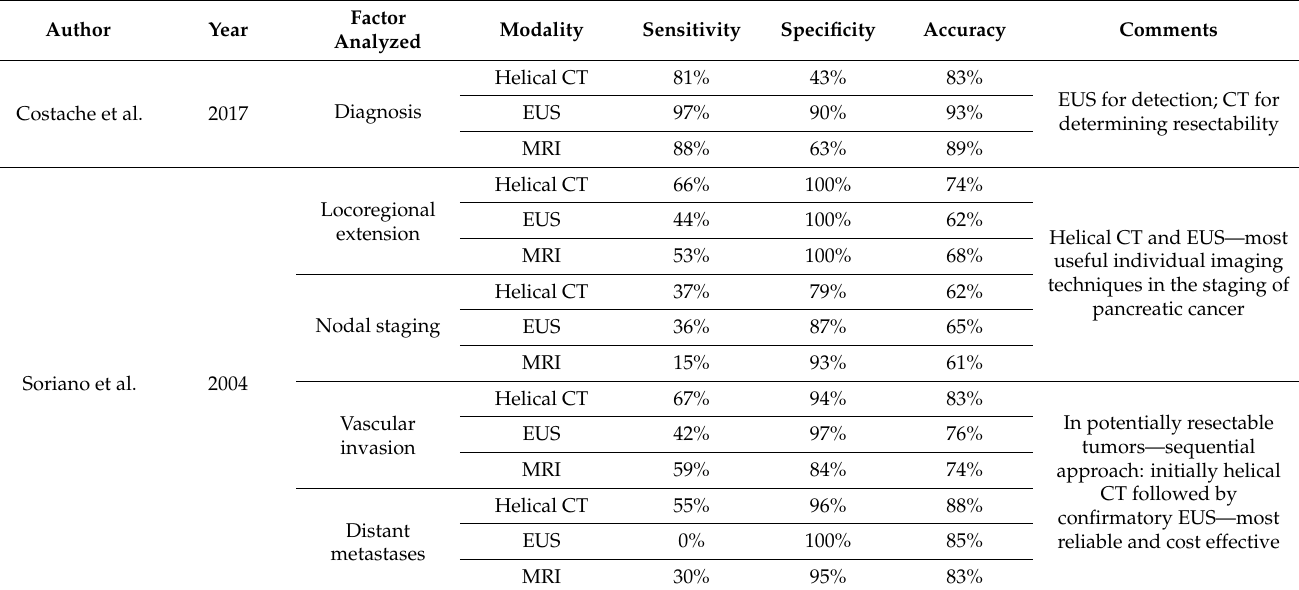
Table 1. State of the art in pancreatic cancer. Abbreviations: computed tomography (CT); endoscopic ultrasound (EUS); magnetic resonance imaging (MRI) at 1.5 or 3 tesla. Data from Shrikhande et al. [20] and Costache et al.